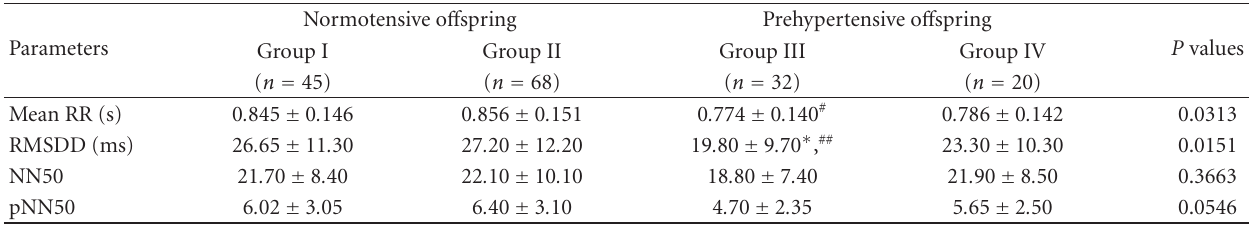
Table 3: Time domain indices of HRV recorded in supine position of normotensive and prehypertensive o ff spring of hypertensive parents. Parameters